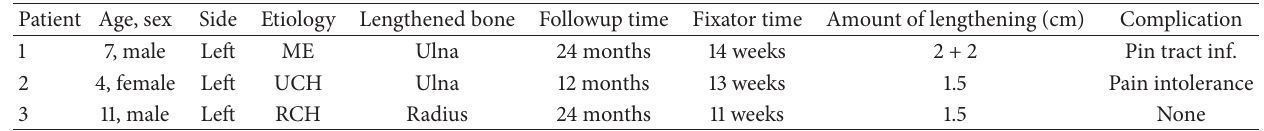
Table 1: Patient characteristics.